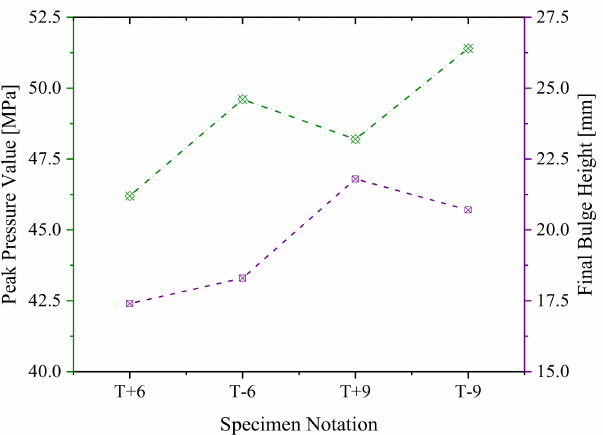
Figure 32. Recorded results of an explosion test: peak pressure value (left side) and final bulge height (right side)